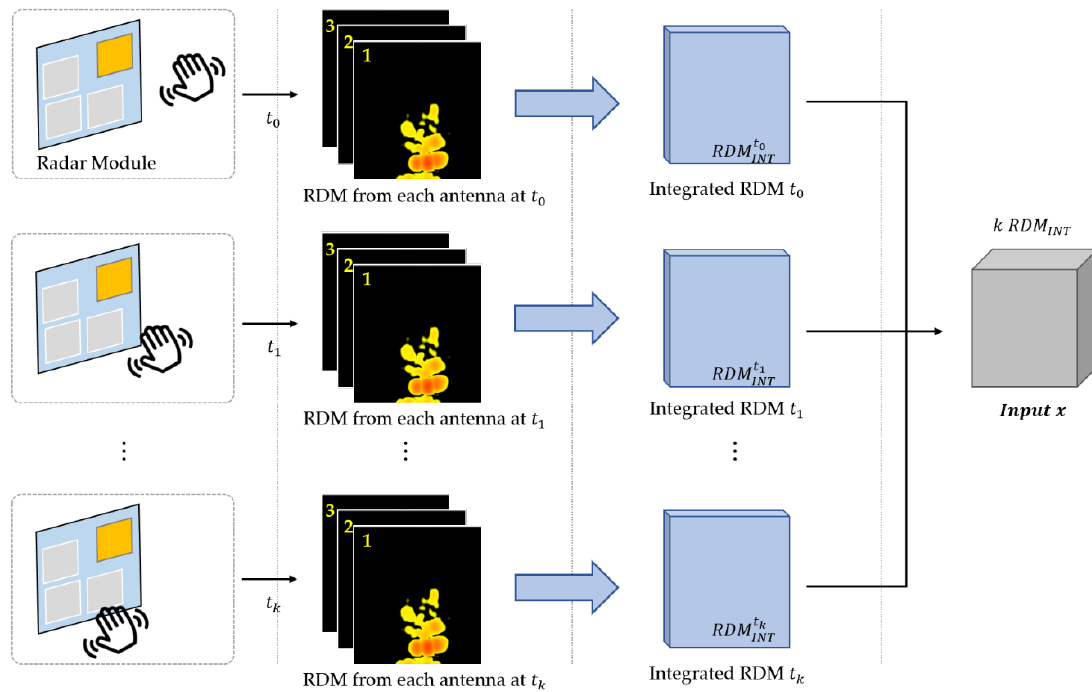
Figure 9. The overview of input dataset collection.